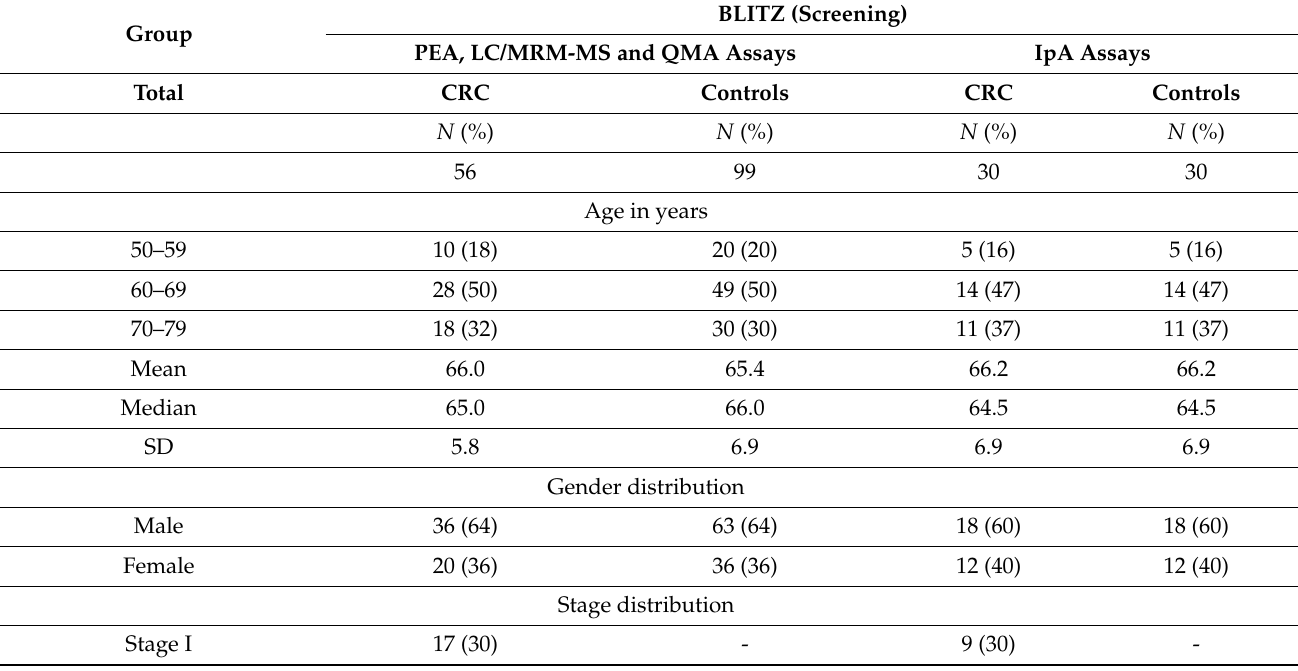
Table 1. Characteristics of the study population from Begleitende Evaluierung innovativer Testverfahren zur Darmkrebs- Früherkennung (BLITZ) participants in screening colonoscopy. BLITZ (Screening) Group PEA, LC/MRM-MS and QMA